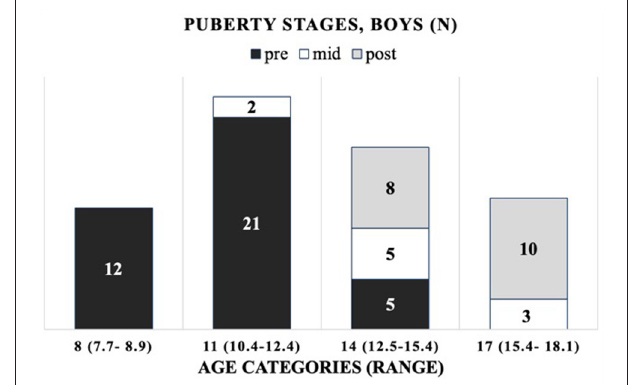
FIGURE 2 | Progression of puberty status per age category for boys ( n per puberty